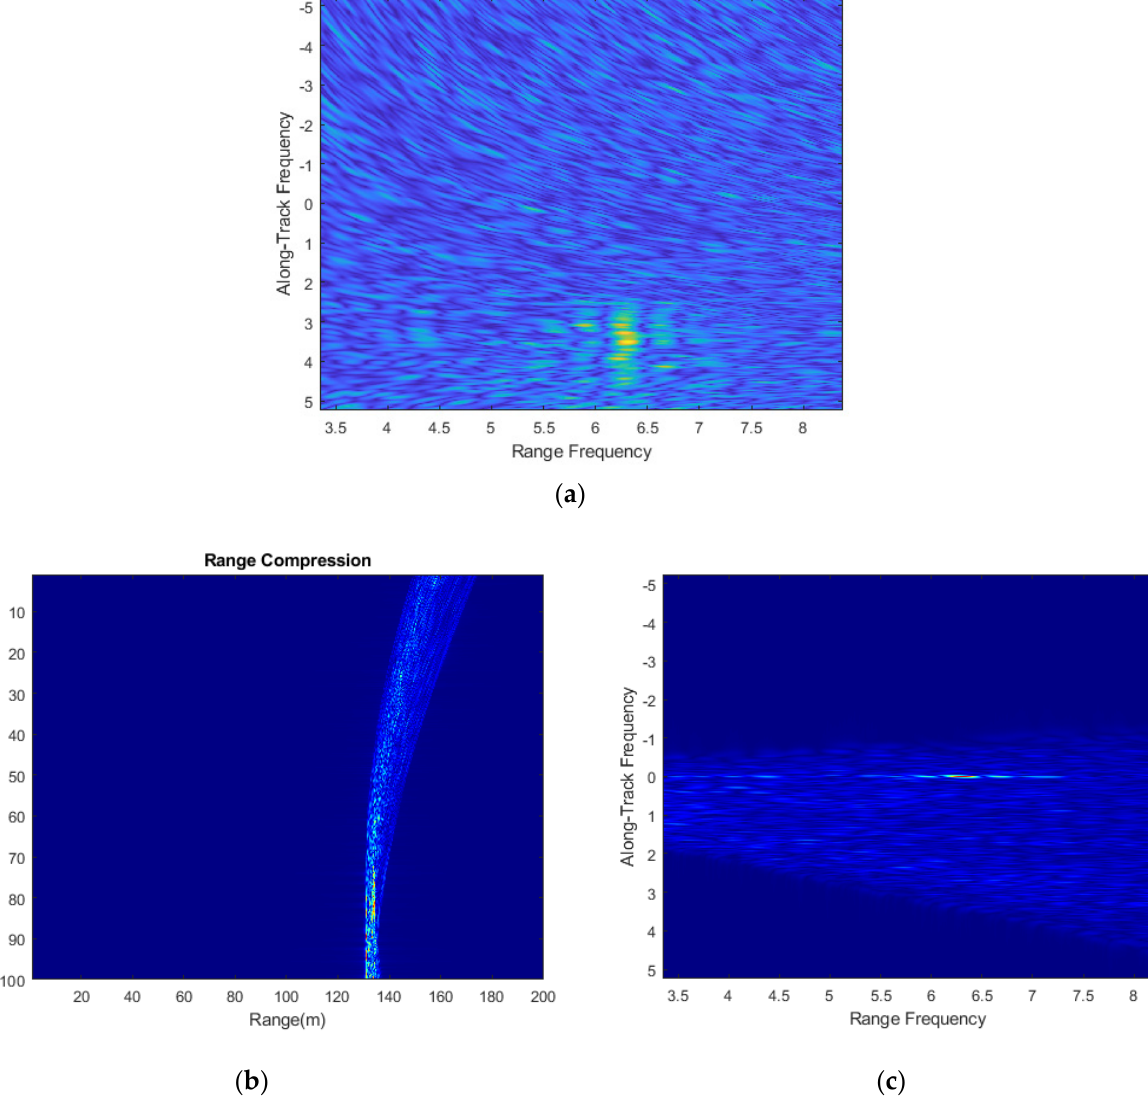
Figure 10. Simulated collected data along SAS of pipeline: ( a ) Simulated data history of along-track and range; ( b ) simulated data history after pulse compression; ( c ) simulated data history after along-track compression.